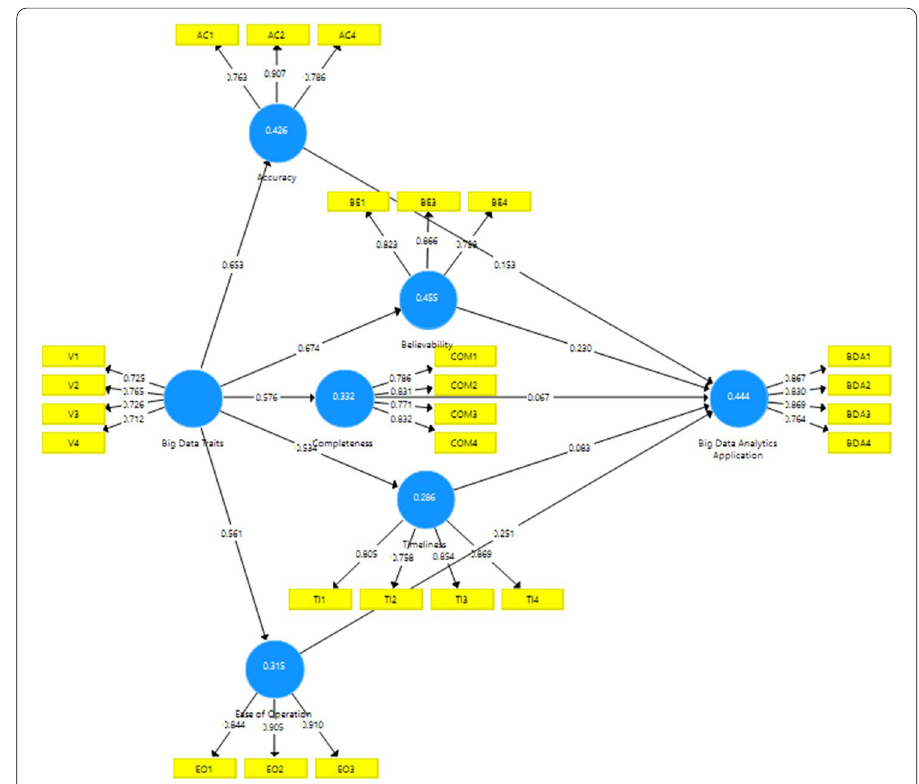
Table 5 The analysis results of the structural model